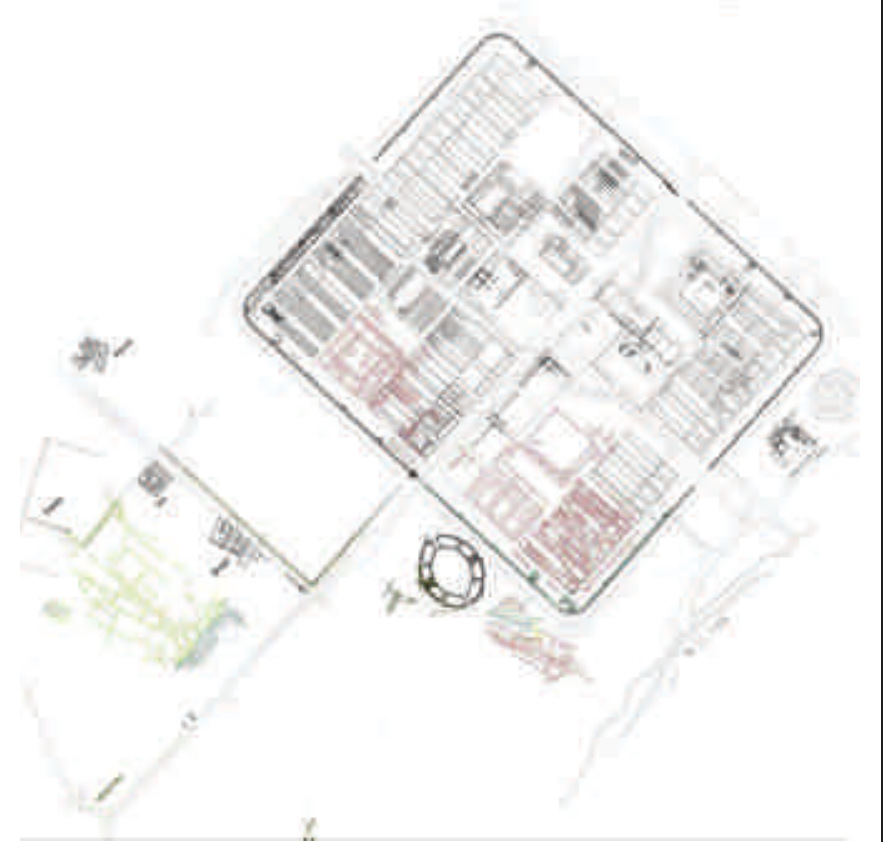
Figure 1 The overall plan of Caerleon, with recent geophysical discoveries highlighted in